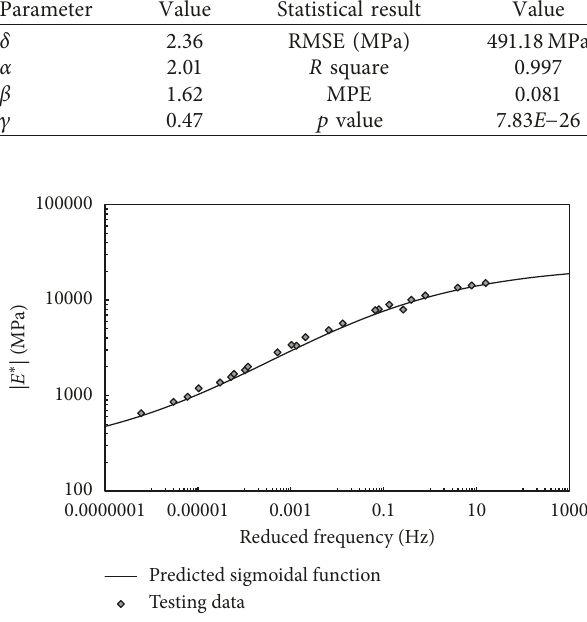
Figure 6: Comparison between measured data of UTM and predicted sigmoidal function.